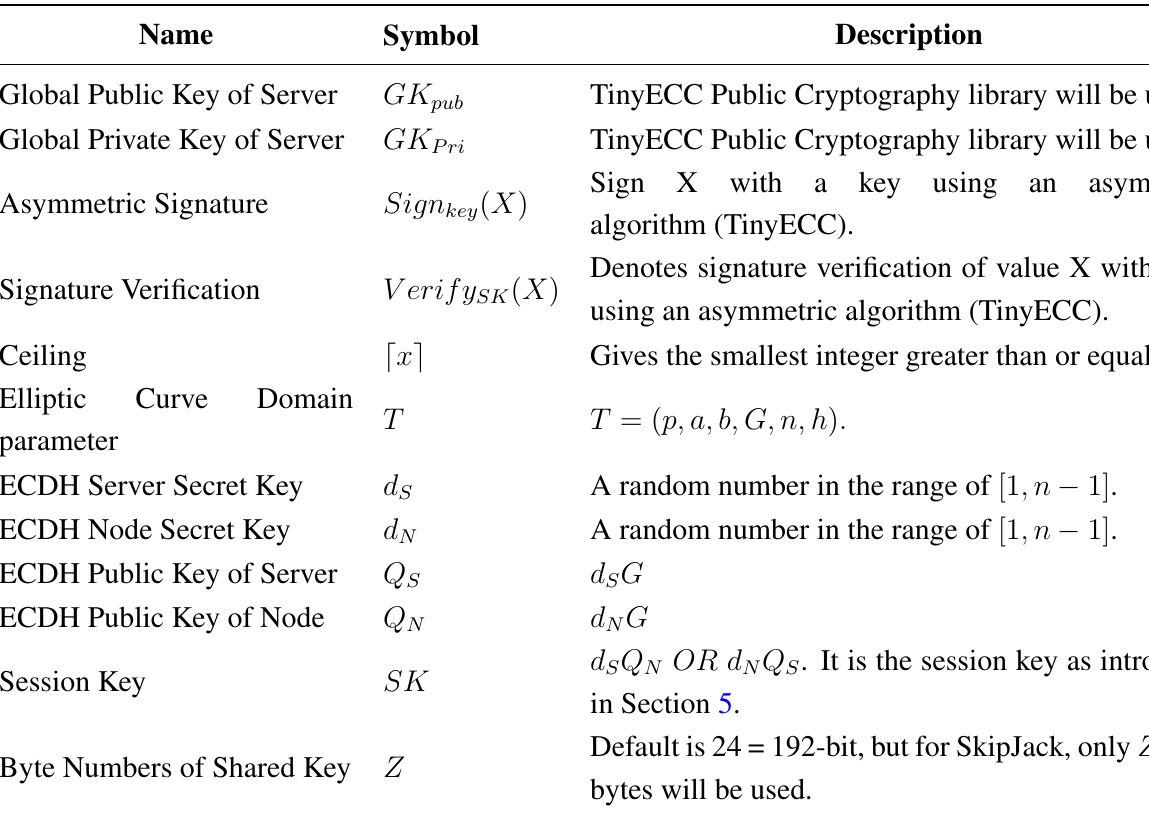
Table 4. Notations. ECC, elliptic curve cryptography; MAC, message authentication